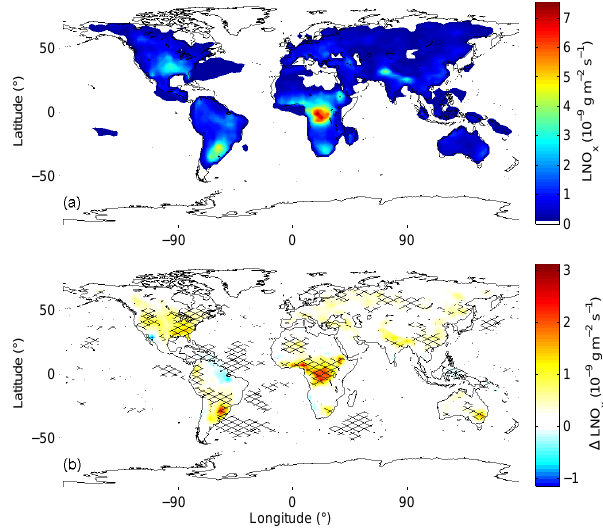
Figure 9. (a) Lightning NO x emissions in the fEmis simulation, averaged over the 1960s; (b) change in lightning NO x emissions in the fEmis simulation, 2090s minus 1960s. Shading indicates that the difference is statistically significant at the 95% level of